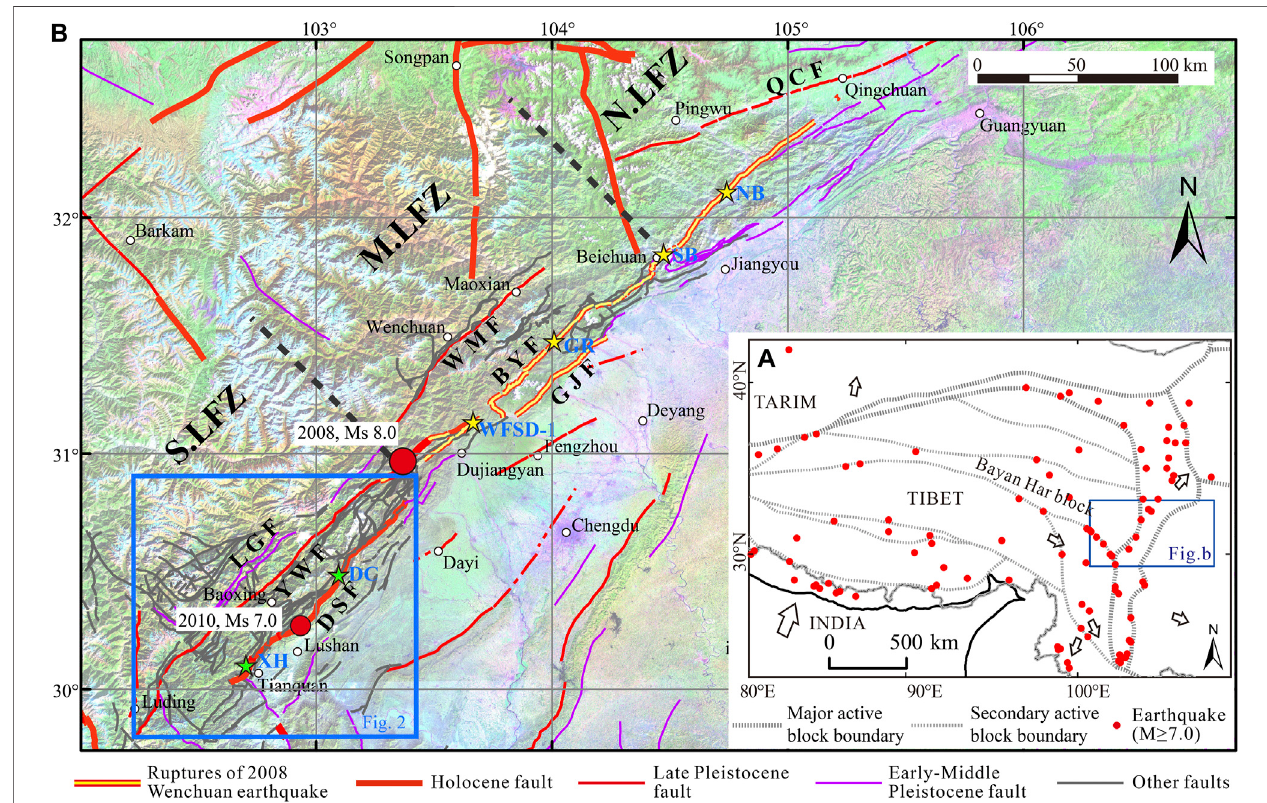
FIGURE 1 | Map showing (A) the location of the study area in Southwest China, along with the tectonic setting and major earthquake ( M ≥ 7) epicenters in the Tibetan Plateau (arrows denote movement directions of active blocks), (B) segmentation of the Longmenshan fault zone (LFZ) and other faults; N. LFZ, M. LFZ, and S. LFZ denote the northern, middle, and southern segments of the LFZ, respectively. Fault names: XKDF: Xinkaidian, SYF: Shiyang, DSF: Dachuan-Shuangshi, YWF: Yanjing – Wulong, LGF: Longdong – Gengda, GJF: Guanxian – Jiangyou, BYF: Beichuan – Yingxiu, WMF: Wenchuan – Maoxian, and QCF: Qingchuan. Green and yellowstarsdenotethefaultgougesamplingsitesfromthisstudyand previousresearch,respectively,XH:Xiaohe,DC:Dachuan,WFSD-1:WenchuanEarthquakeFault Scienti fi cDrillingHole-1(LiH.etal.,2013;Sietal.,2014;WangH.etal.,2014;Chenetal.,2016;Liuetal.,2016),GR:GoldenRiver(Duanetal.,2016),SB:Shaba(Yuan et al., 2013), and NB: Nanba (Han et al., 2010).